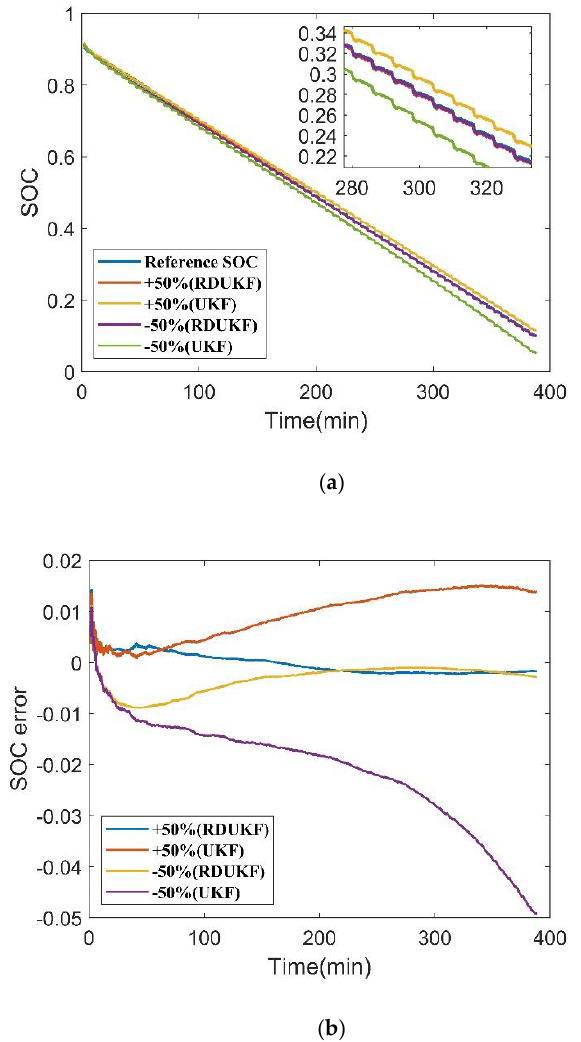
Figure 6. ( a ) SOC estimation results according to deviations in R1; ( b ) SOC error according to deviations in R1.